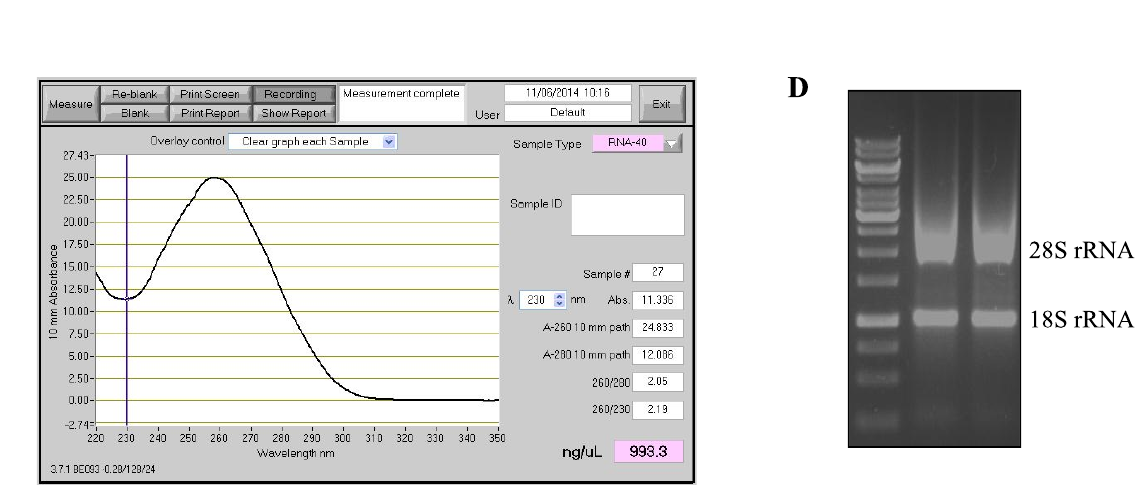
Figure 4. Considerations to comply with during RT-qPCR. ( A ) Representative graph of assay efficiency check. ( B ) Graph representing the inhibition test for all biological samples. ( C ) Representative graph from Nanodrop Spectrophotometer displaying the quantity and purity of the RNA. ( D ) Representative image of non-denaturing agarose gel displaying the 28S:18S ribosomal RNA ratio for RNA